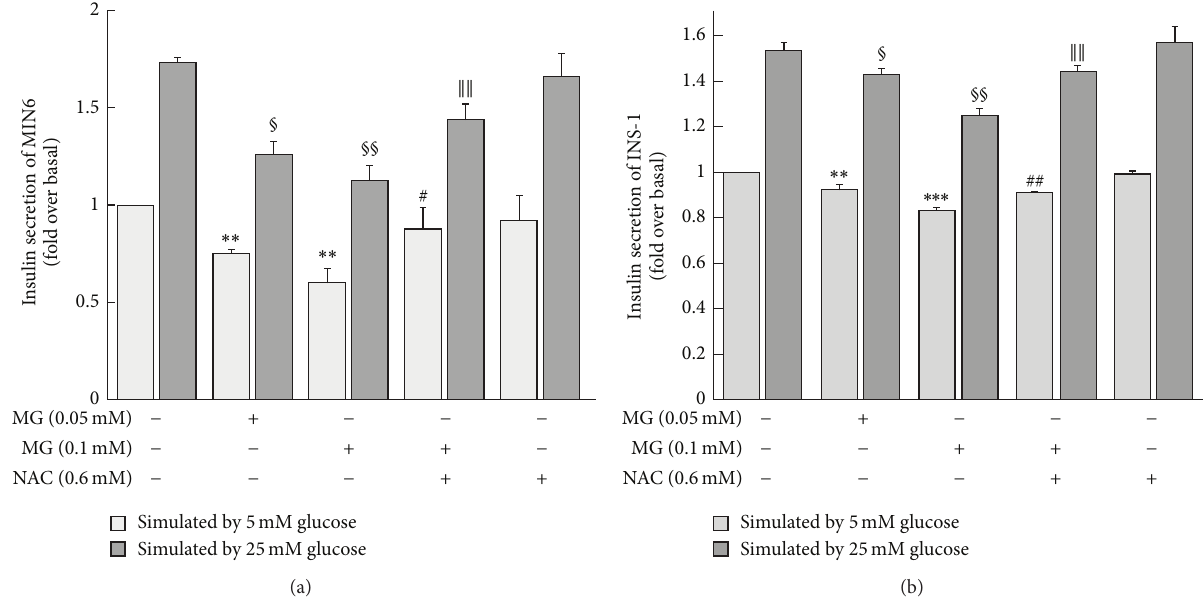
Figure 1: Effects of MG on insulin secretion by MIN6 (a) and INS-1 (b) cells. Insulin secretion stimulated by low glucose concentration (5mM) or high glucose concentration (25 mM) was reduced by preincubation with MG. The effects of MG on MIN6/INS-1 were dependent on the concentration of MG and were reversed by coincubation with NAC. ∗ 𝑝 < 0.05 , ∗∗ 𝑝 < 0.01 , and ∗∗∗ 𝑝 < 0.001 compared to control group (0mM MG + 0mM NAC) with 5 mM glucose stimulated. # 𝑝 < 0.05 , ## 𝑝 < 0.01 compared to the higher MG group (0.1mM MG + 0 mM NAC) with 5 mM glucose stimulated. § 𝑝 < 0.05 , §§ 𝑝 < 0.01 compared to control group (0mM MG + 0 mM NAC) with 25 mM glucose stimulated. ‖‖ 𝑝 < 0.01 compared to the higher MG group (0.1mM MG + 0mM NAC) with 25 mM glucose